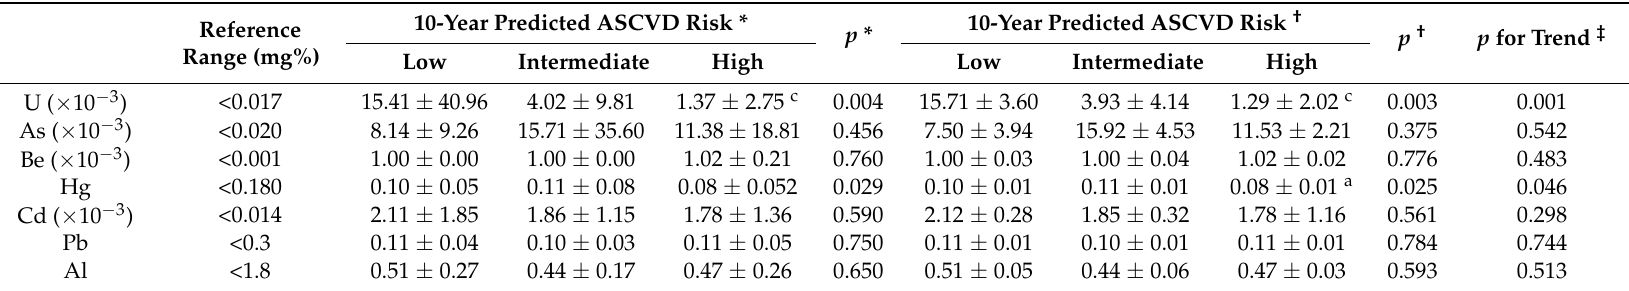
Table 4. Concentrations of eight toxic elements in hair in the three groups of subjects stratified by severity of ASCVD